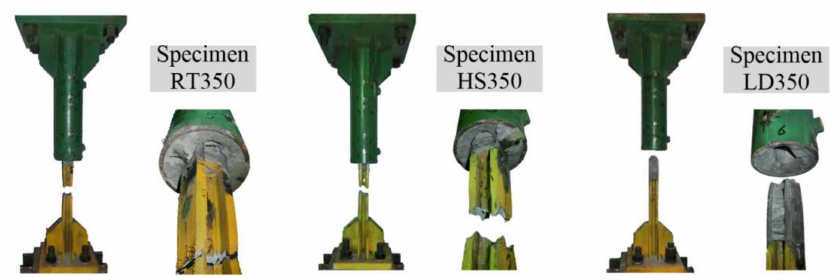
Figure 9. Failure mode of steel profile fracture for Specimens RT350, HS350 and LD350.